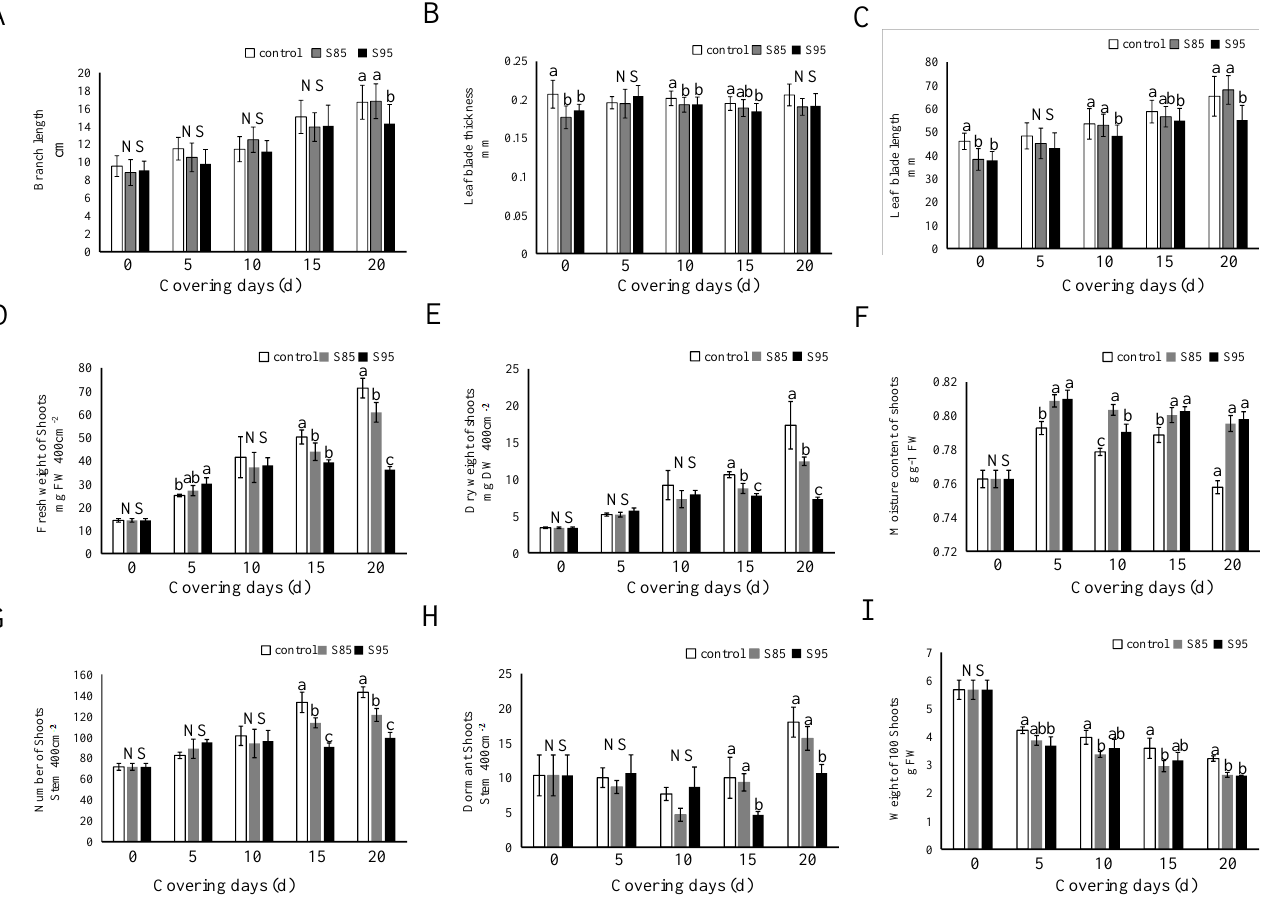
Figure 2. Effects of shading on tea leaf morphology and traits. ( A ) Branch length; (B ) Leaf thickness; ( C ) Leaf length; ( D ) Fresh weight; ( E ) Dry weight; ( F ) Water content; ( G ) Number of branches (400 cm 2 ); ( H ) Number of dormant branches (400 cm 2 ); ( I ) 100-bud weight. ‘NS’ and different letters above the bar indicate insignificant and significant ( p < 0.01; n = 3 biological replicates) differences, respectively, between the control and shaded plants.